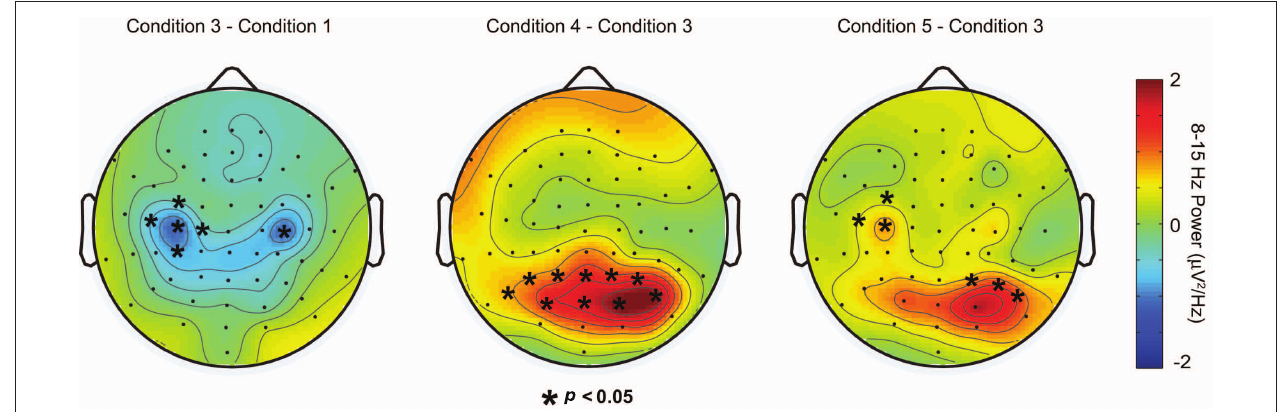
Figure 4 | results of cluster analysis plotted over the difference in delay-period alpha-band power between, from left to right, Conditions 3 and 1, 4 and 3, and 5 and 3, respectively. Asterisks overlayed on each topoplot indicate sensors showing significant differences in delay-period alpha power